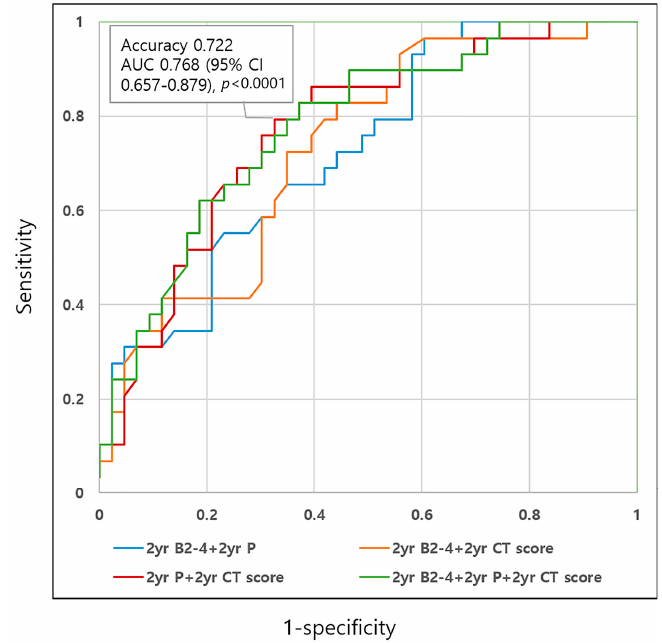
Figure 3. ROC analysis for unfavorable disease course using selected disease parameters. Combining 2-year perianal disease with 2-year moderate-to-severe CT activity scores showed the highest accuracy (0.722) and AUC (red line, 0.768, p < 0.0001), which is comparable to those of the combination of all the three variables (2-year B2-3, 2-year perianal disease, and 2-year moderate-to-severe CT scores, green line, 0.779, p <